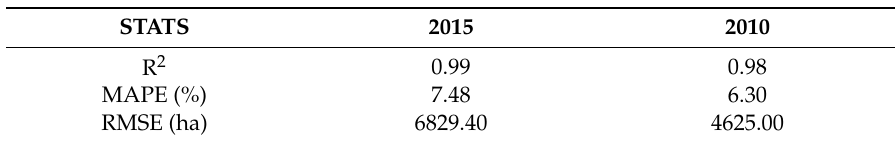
Table 3. Coefficient of determination (R 2 ), MAPE and RMSE between NASS and NEG estimated county irrigated area for 2015 and 2010.